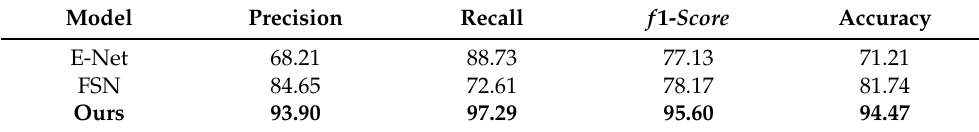
Table 2. Performance comparison.